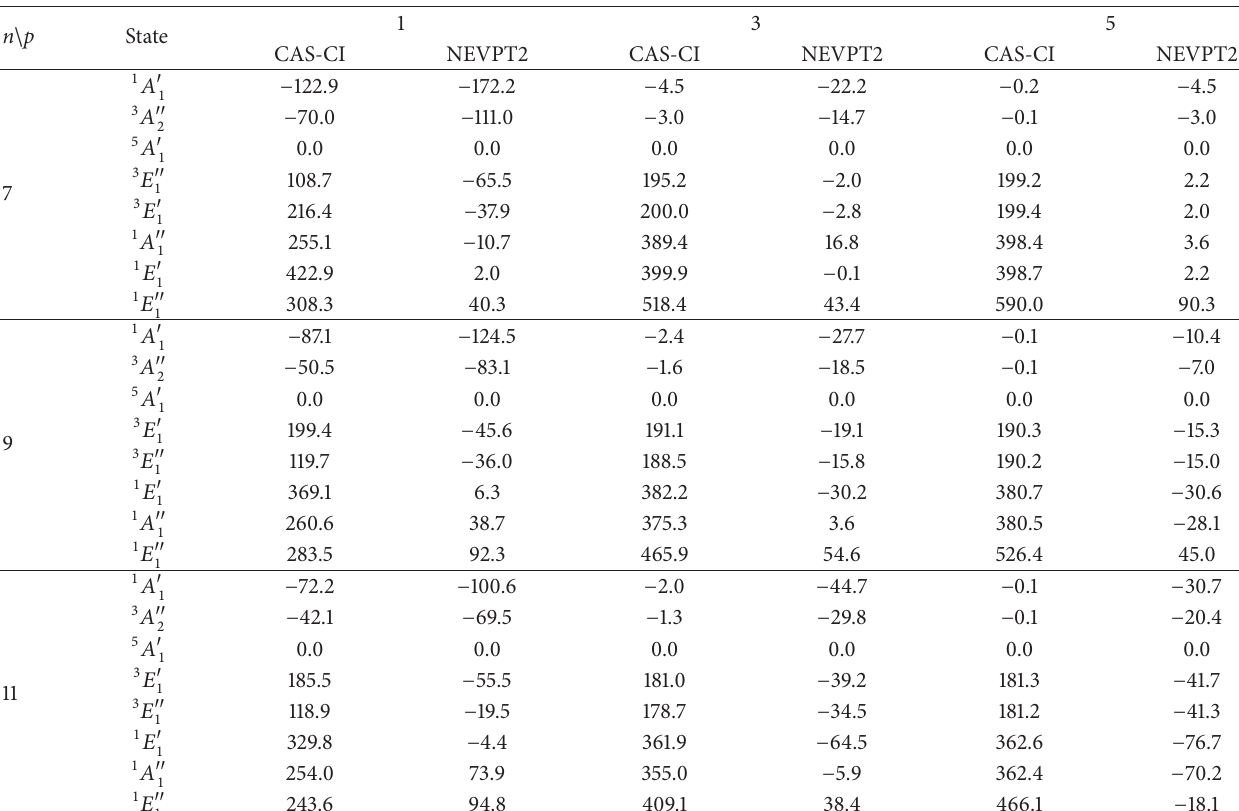
Table 5: CAS-CI and the NEVPT2 energies in kJmol −1 for the class of nanotubes 𝑛 𝑝 , with 𝑛 odd and 𝑝 odd. All possible states for a CAS of four electrons in four orbitals have been calculated.